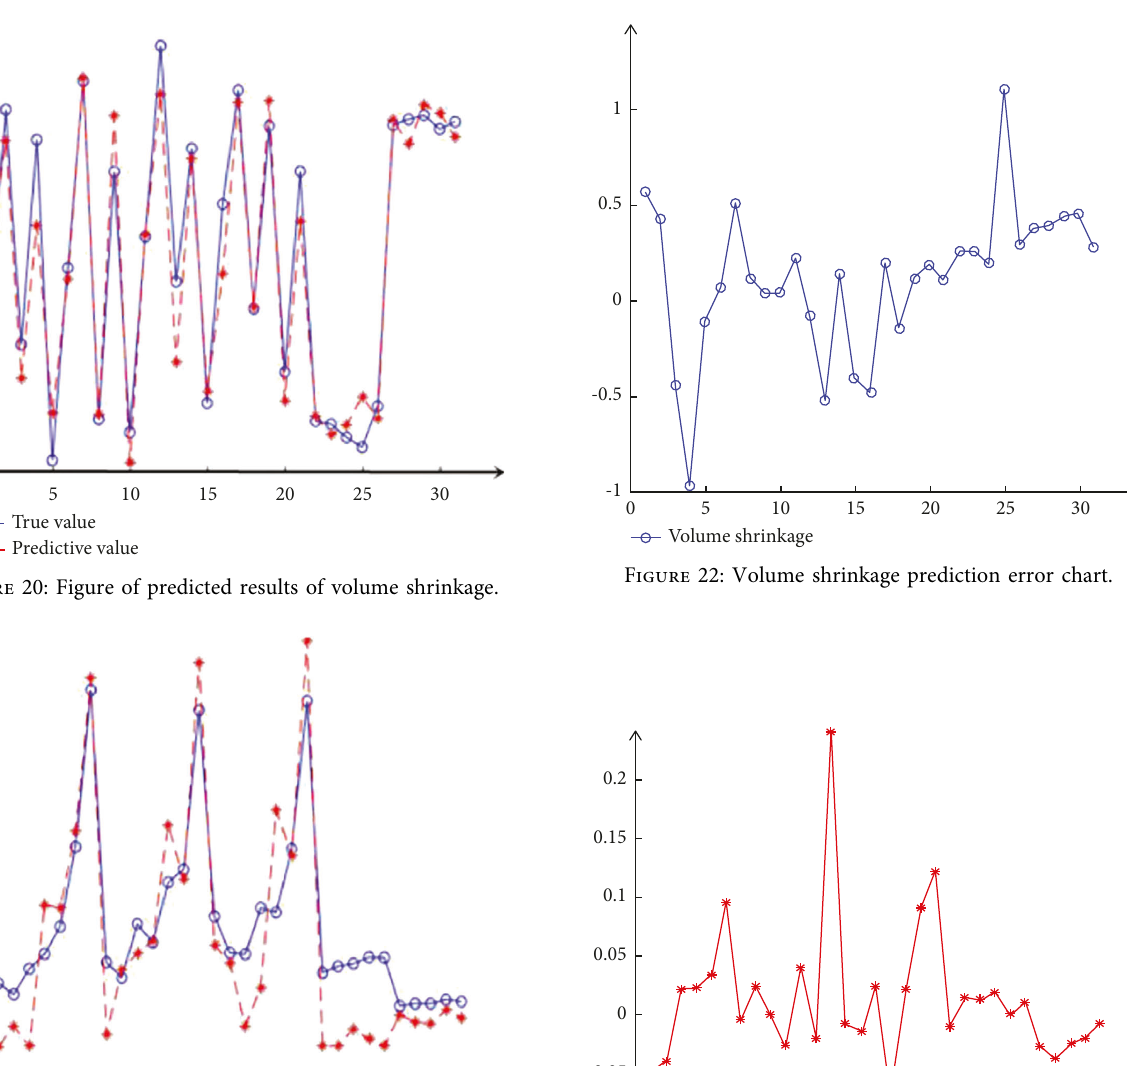
Figure 19: Structure diagram of BP neural network model.